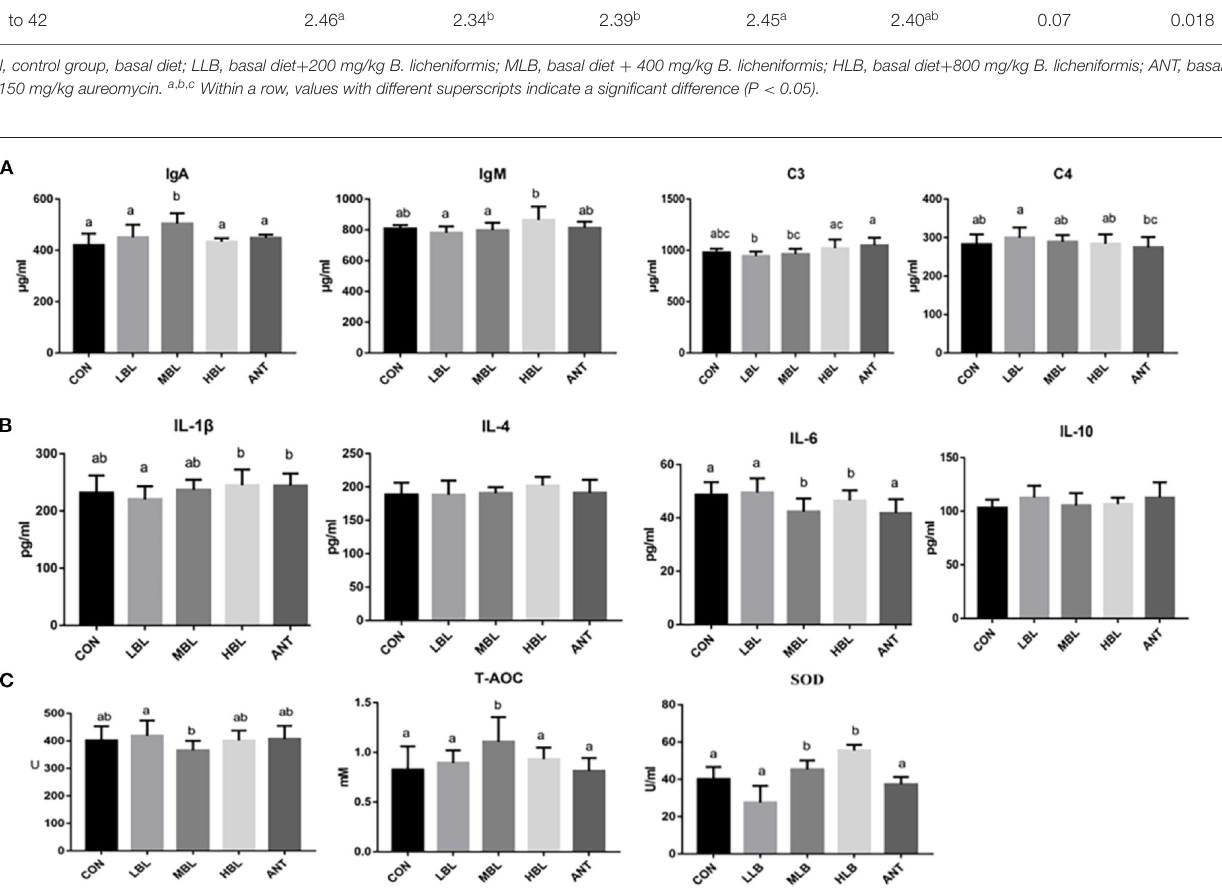
Frontiers in Veterinary Science |